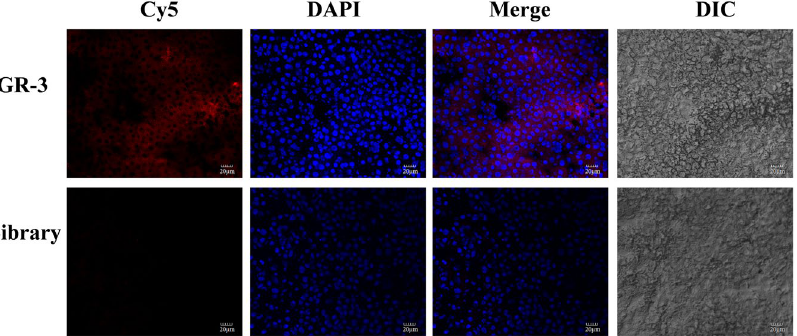
Figure 7. Representative fluorescence images of liver tissue sections stained with Cy5-labled GR-3 or library (250